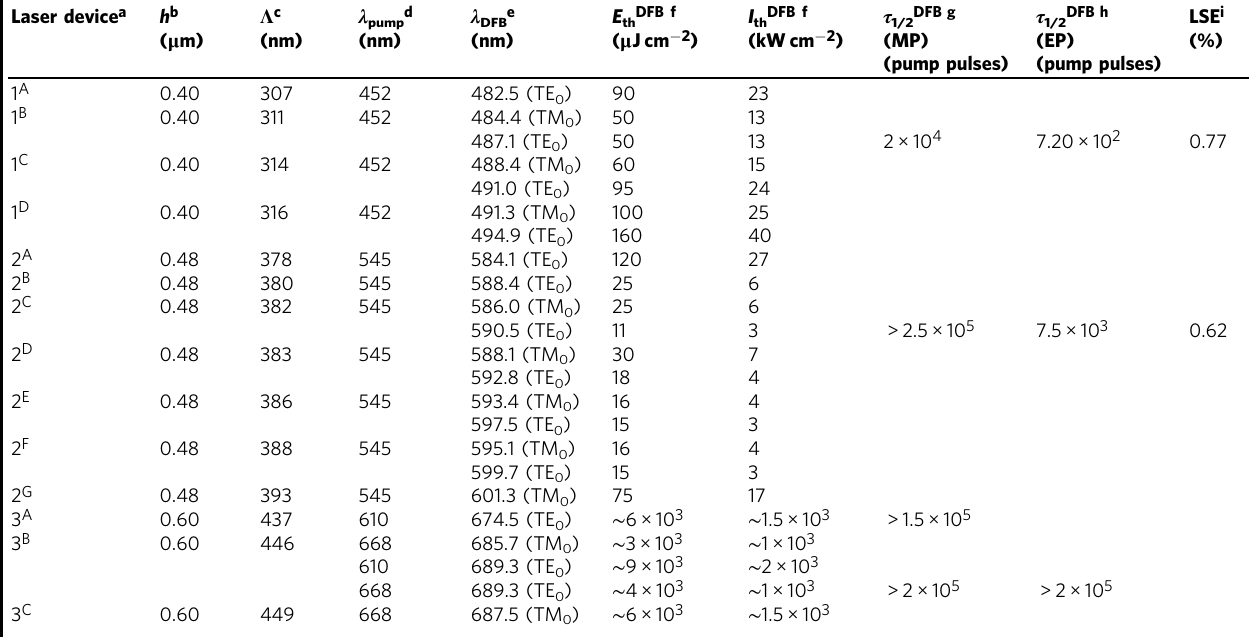
Table 2 Parameters of top-layer resonator distributed feedback (DFB) lasers based on nanographenes as active media Laser device